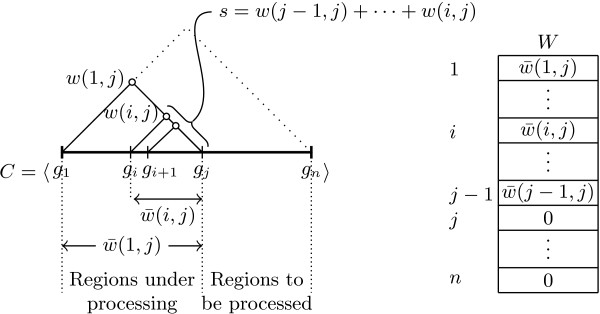
Processing a chromosome with the MIG algorithm. A chromosome is processed from left to right, and gj is the current SNP. Values in W [i] correspond to the region weights w¯(i,j) of 〈gi, …, gj〉. s accumulates SNP-pair weights w(j - 1, j), …, w(i, j).